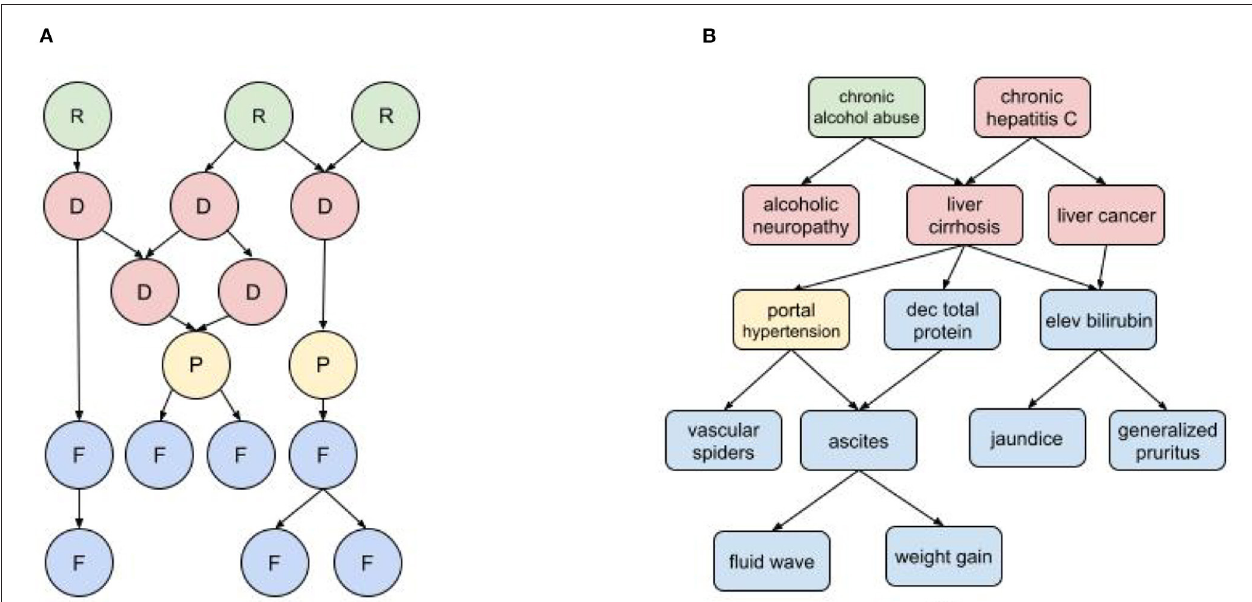
FIGURE 1 | Diagnostic BN hierarchy (A) Generic fragment where each node represents a risk factor (R) disease (D), pathophysiological state (P), or findings (F); (B) BN fragment for liver cirrhosis.